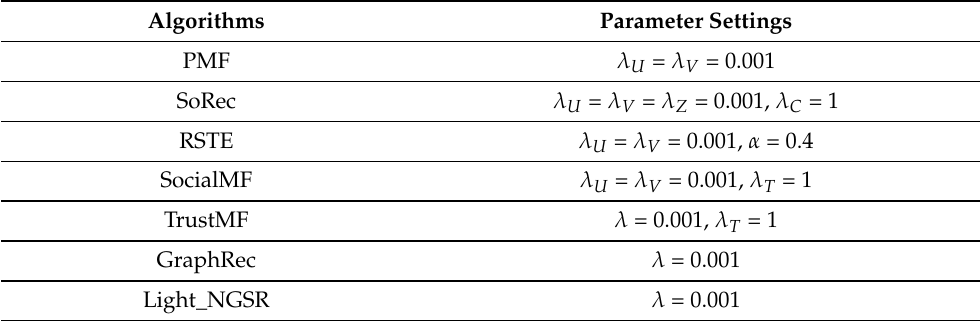
Table 2. Parameter settings of the methods used for comparison.